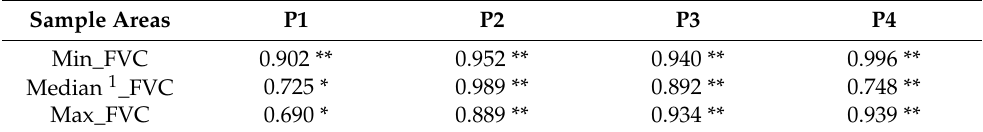
seven metrics in Table 3 with a correlation coefficient of 0.690 (the red fitting dotted line, seven metrics), and the correlation coefficient was 0.999 after excluding the larger discrete metrics NP and CONTAG (the blue fitting dotted line, five metrics). Table 6. Correlation coefficient ( r ) between FVC and LST landscape pattern metrics at P1–P4. Sample Areas P1 P2 P3